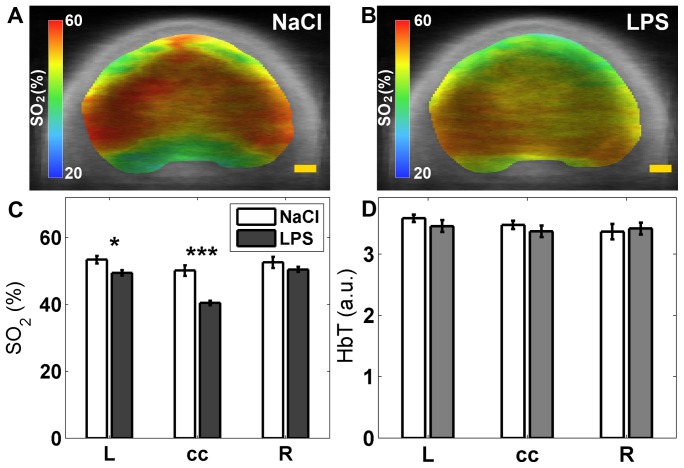
Locoregional cortical saturation (SO2%) following LPS exposure.(A) Group averaged SO2 weighted PAT image for sham controls (NaCl), (B) Group averaged SO2 weighted PAT image for LPS group, (C) SO2 Comparison performed between LPS group (N = 11), and NaCl (sham) group (N = 8). SO2 showed significant decrease in the LPS group compared to NaCl group in left cortex (L) and corpus callosum (cc). The hemisphere contralateral (R) to injection showed no difference. (D) HbT comparison between LPS and NaCl groups, no significant differences were found in any of the explored ROIs. Scale bar: 1 mm; *P<0.05, ***P<0.001.